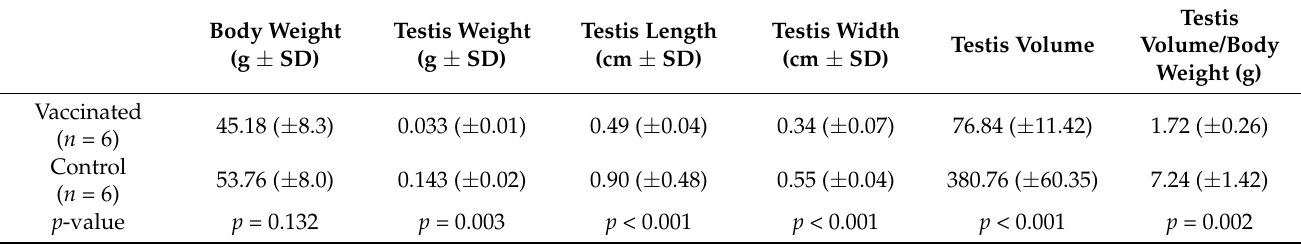
Table 1. Between-group comparison of testis weight, length, width, volume, body weights, and testis volume/body weight (g) ratio. Testis weight, volume and testis volume/body weight ratio in the vaccinated group was significantly lower than that in the control group (Mann–Whitney rank sum test); testis length, and width also showed significantly lower than the control group (Student’s t